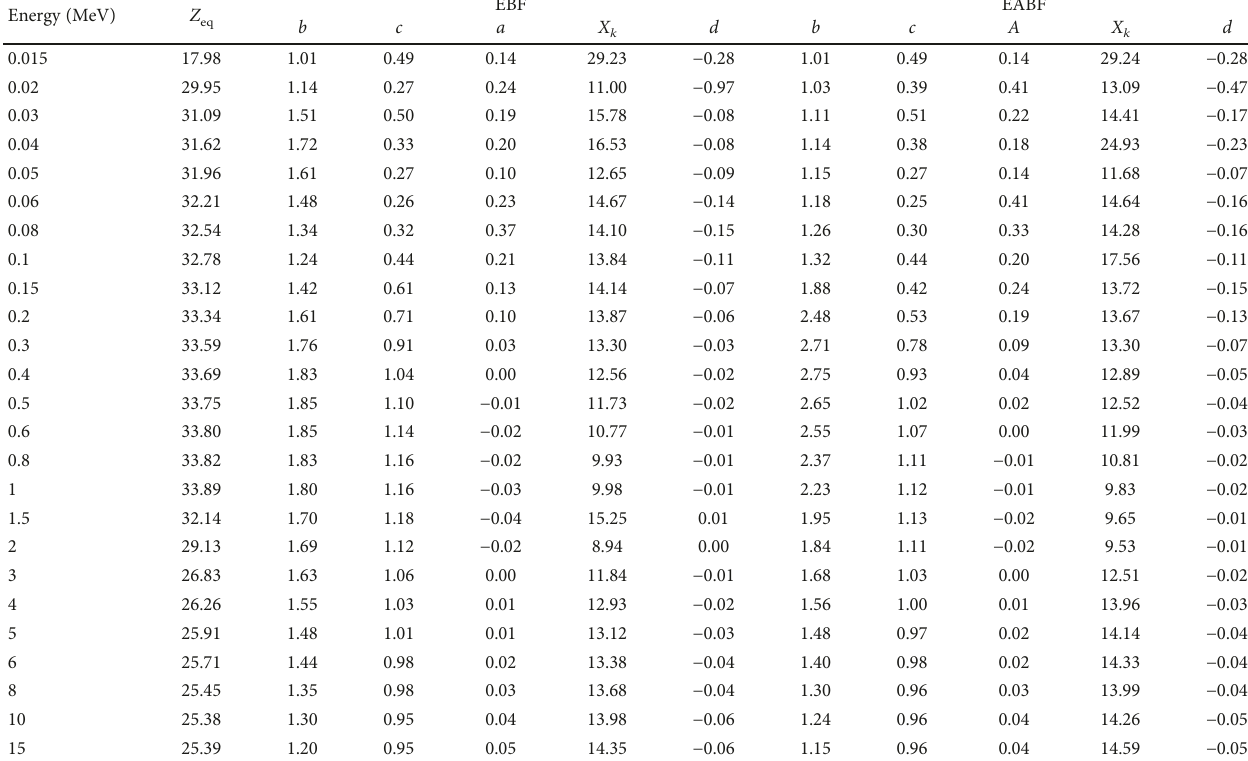
Table 5: Equivalent atomic number ( Z ) and G-P exposure (EBF) and energy absorption (EABF) buildup factor coe ffi cients of CMO. eq Energy (MeV) Z